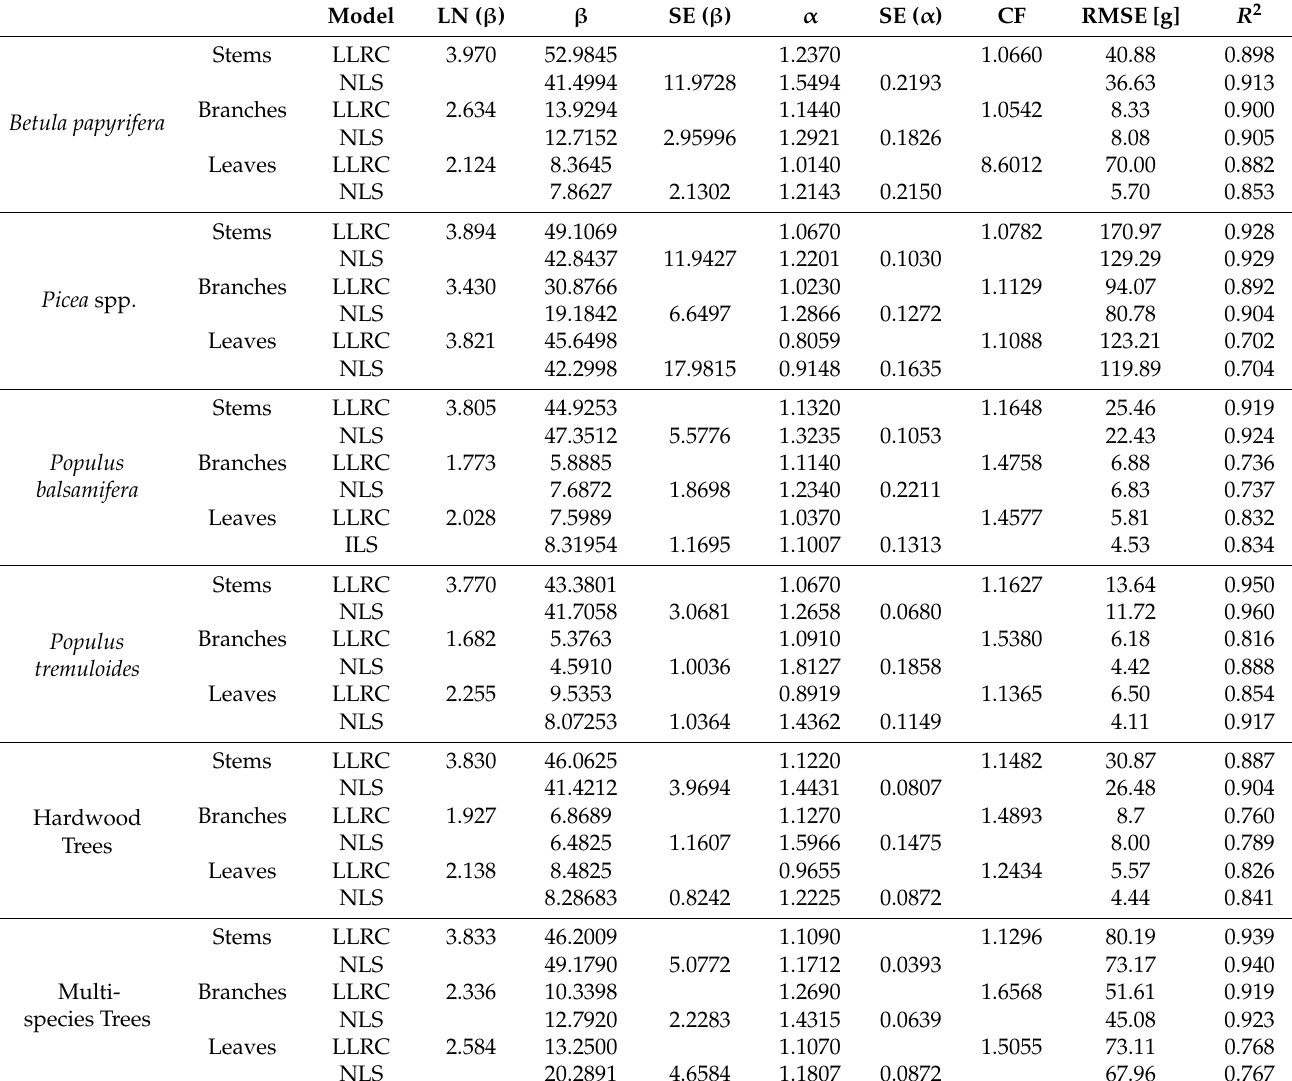
Table 3. Regression coefficient estimates with error statistics based on cross-sectional area to be input into Equations (2)–(5) as appropriate to derive short-stature tree component